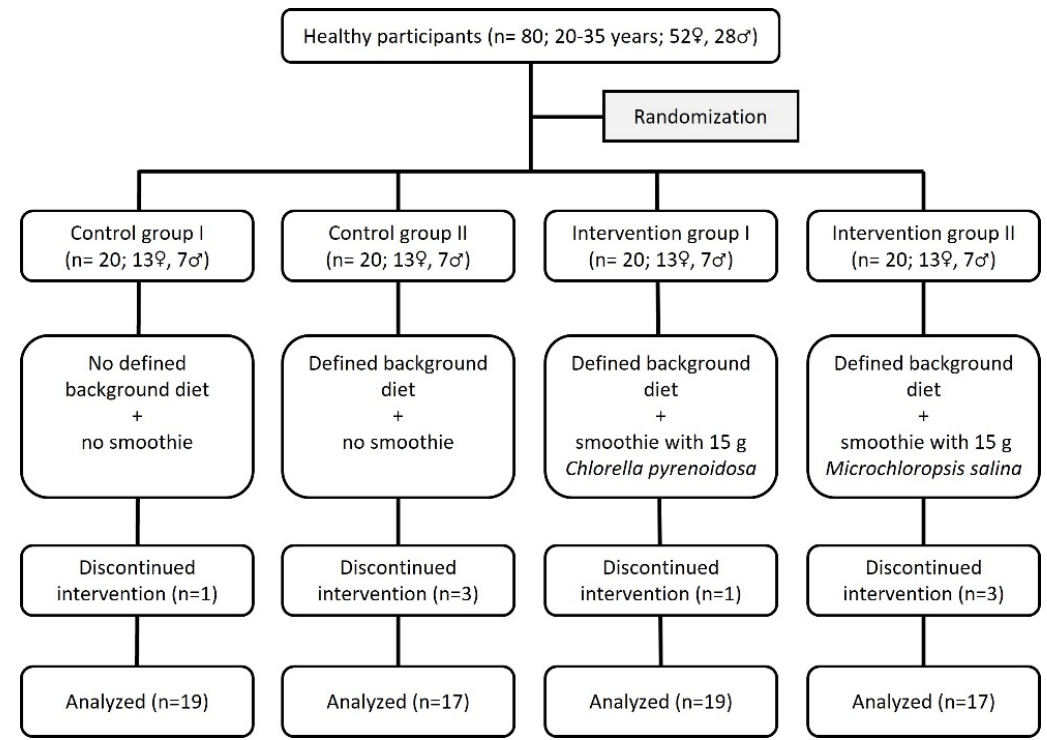
Figure 3. Flow chart of the NovAL study.